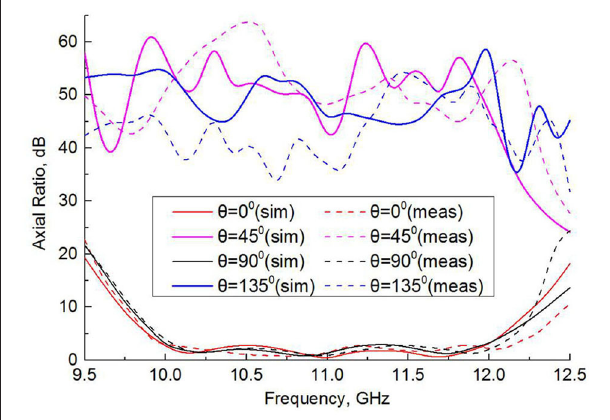
FIGURE 8 | Measured and simulated axial ratio with different rotation angle.